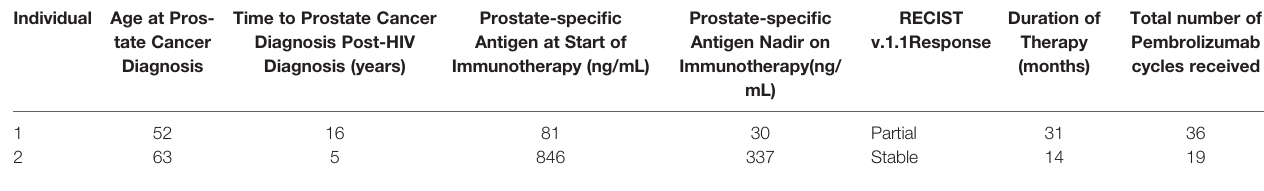
Individual Age at Pros- tate Cancer